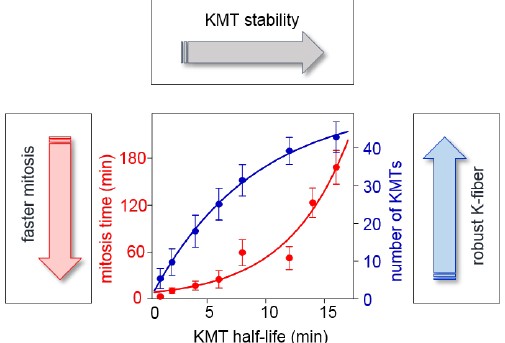
Figure 5. Competing constraints on KMT turnover during mitotic progression. Graph illustrates how KMT turnover (represented as KMT half-life, horizontal axis) affects the overall speed of mitosis and the total number of acquired KMTs (based on the error-correction model in [23]). The speed of mitotic progression (left axis) is evaluated based on the time required to achieve the steady-state KMT configuration. At steady state, the number of attached KMTs (right axis) and the fraction of merotelic KMTs (not shown) have stopped changing, and increasing the duration of mitosis does not generate more KMTs or improve accuracy. When KMT turnover is slow, i.e., KMT half-life is longer, attachments are more stable because they have low release rate. The time required to release all old KMTs increases quickly with increasing KMT stability (red curve), so shorter KMT lifetime is required for speedy mitotic progression. However, the number of KMTs in a K-fiber is lower for shorter KMT lifetime (blue curve). Thus, the limited time of mitotic progression and the acquisition of a full set of KMTs represent the competing constraints on the rate of KMT turnover during mitosis.